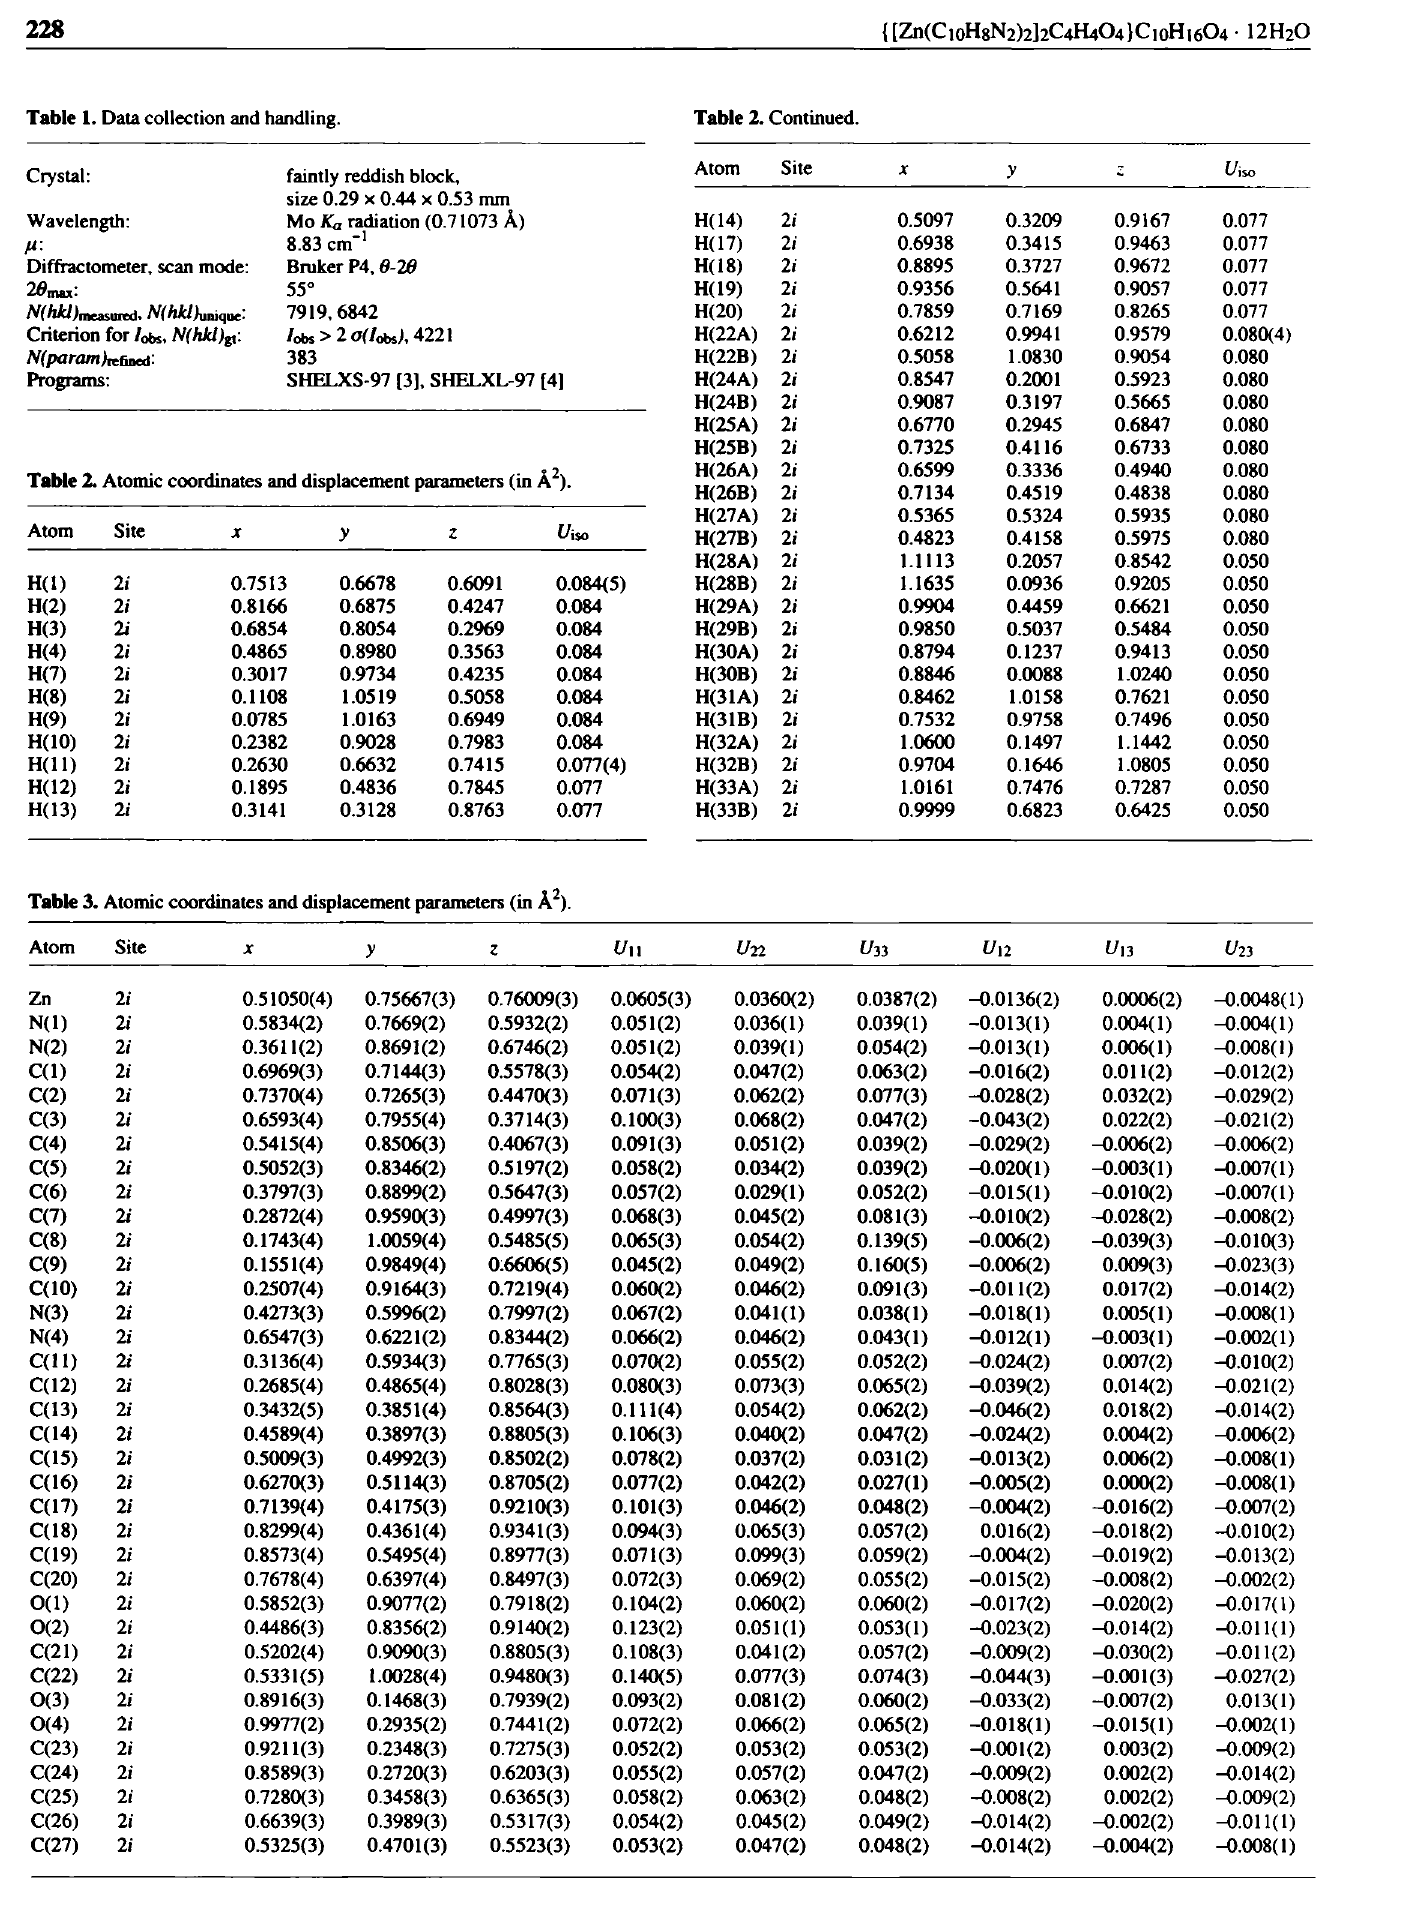
Table 2. Atomic coordinates and displacement parameters (in Â 2 ).